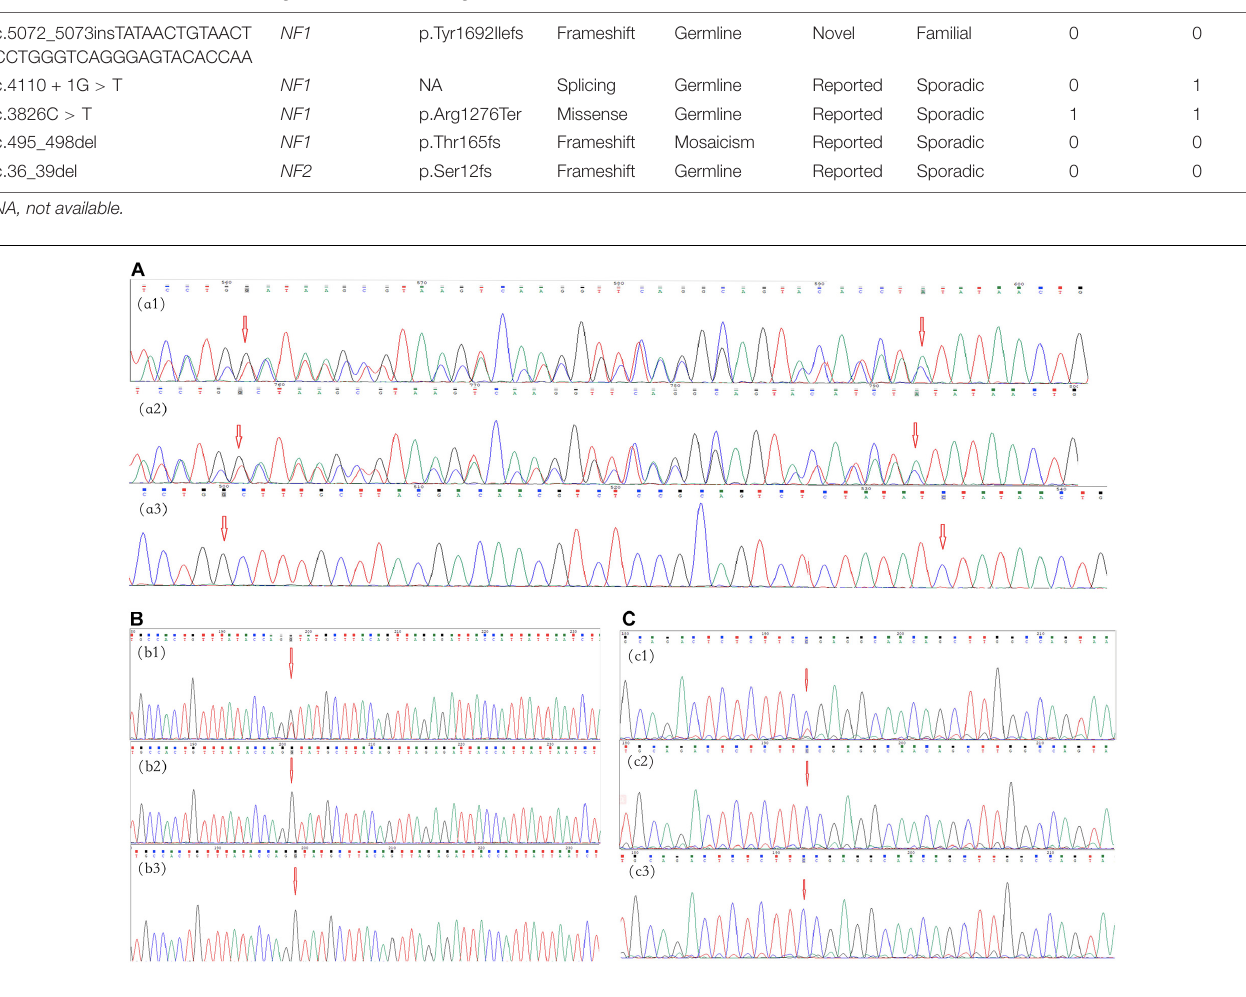
Amino acid gene change